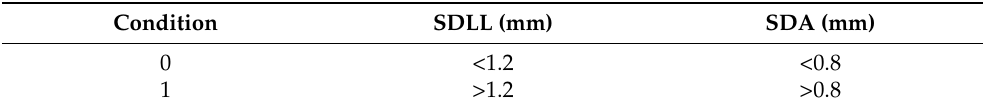
Figure 9. Boxplots and histograms of standard deviations of the longitudinal level and the alignment of right and left rails. Table 2. Definition of geometrical track quality condition ( C